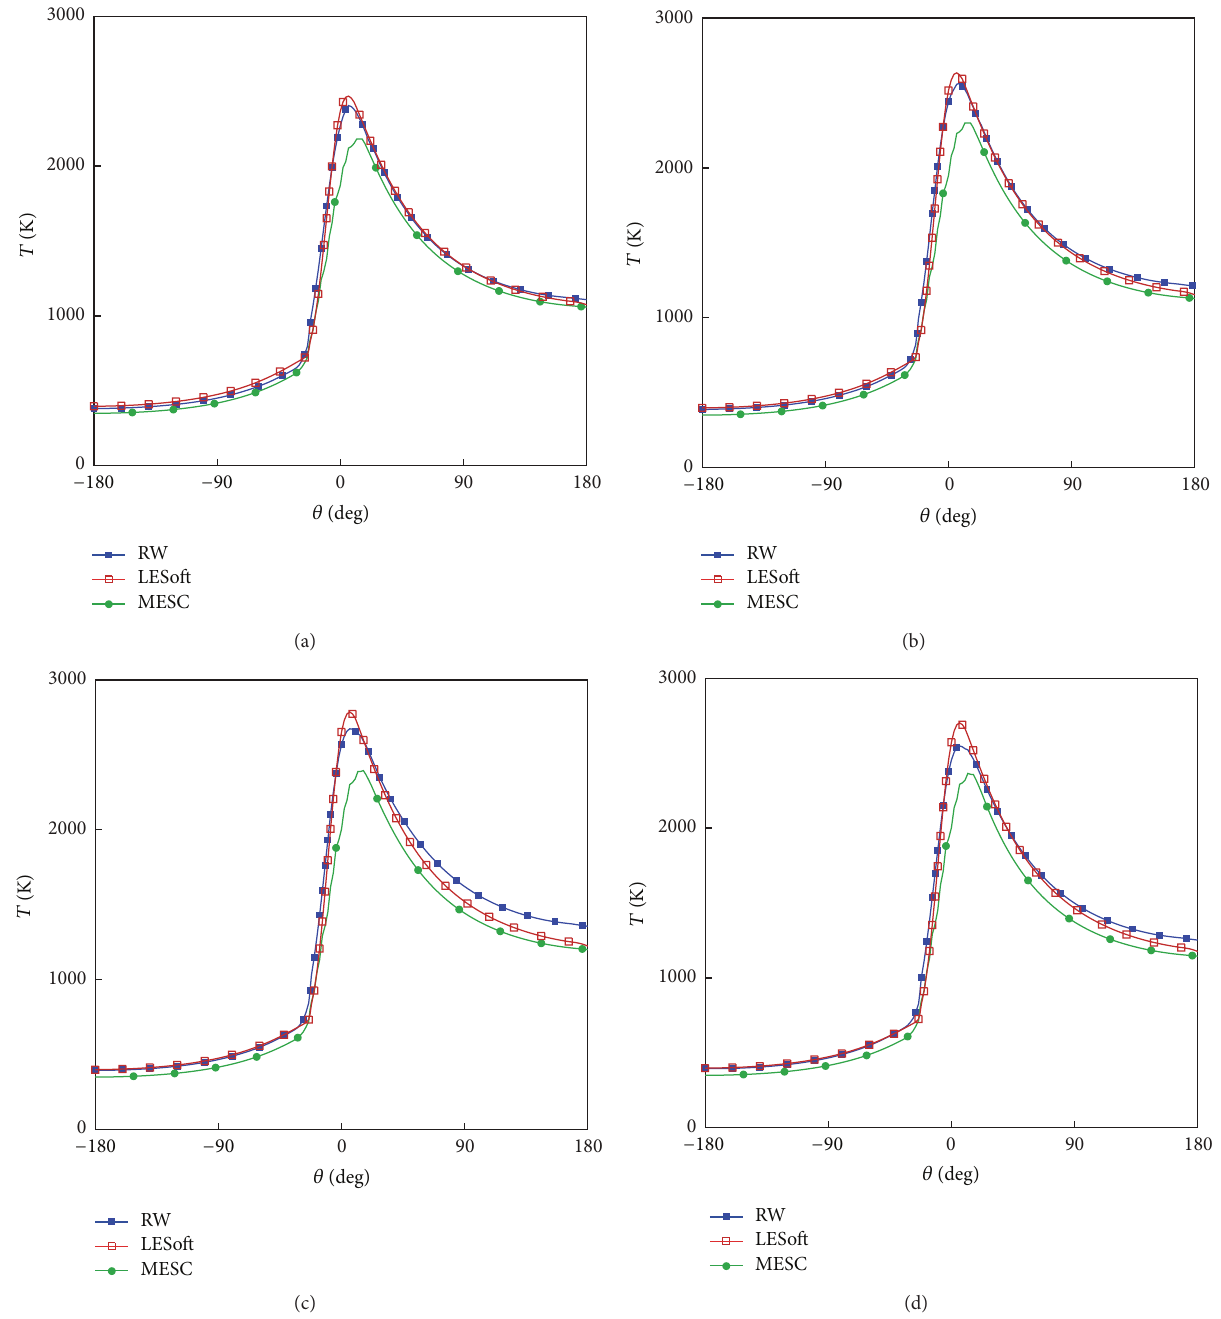
Figure 14: Profiles of temperature for air to fuel ratios of 0.8 (a), 0.9 (b), 1.0 (c), and 1.1